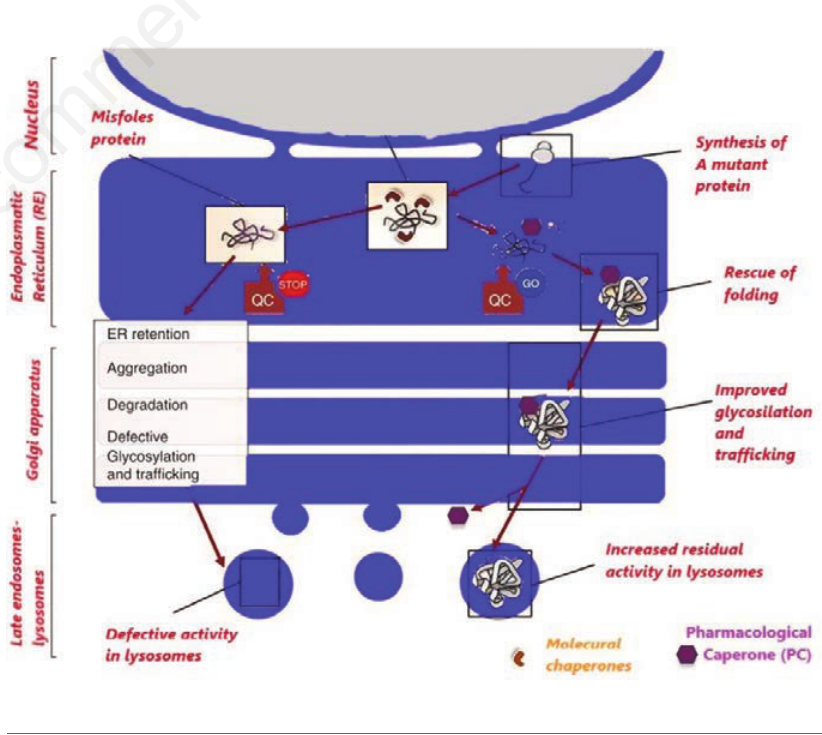
Figure 1. Mechanism of action of pharmacological chaperones. Pharmacological chaper- ones are molecules that act binding the mutant stability and favoring its transfer to the lysosomes thus increasing residual activity in